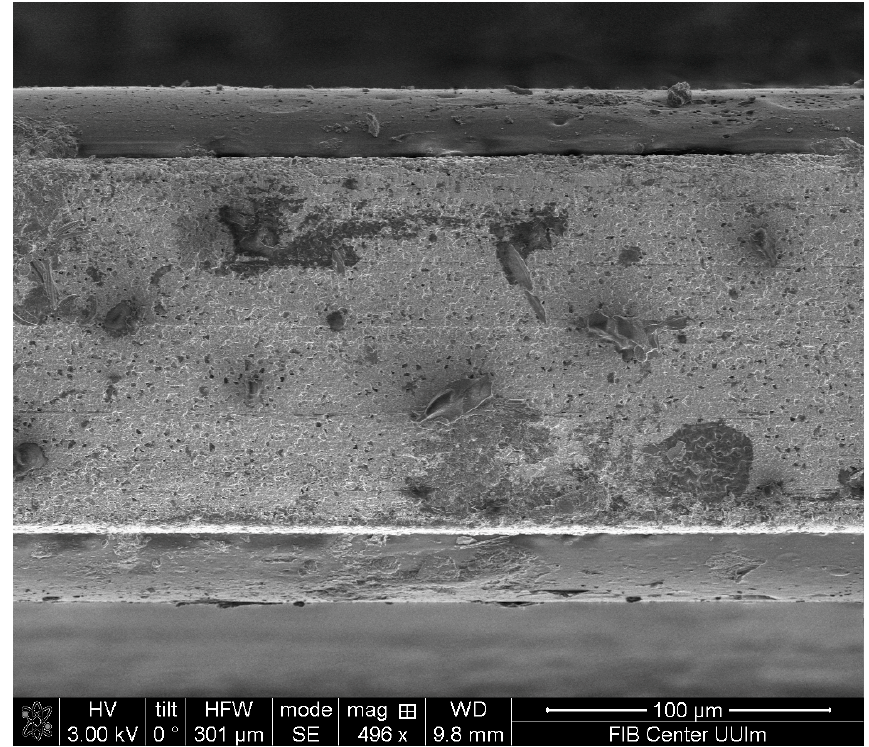
Figure 2. Scanning electron microscopy image of the cross-section of a AgX fiber with the E/P-co polymer coating on the top and bottom revealing a uniform layer.